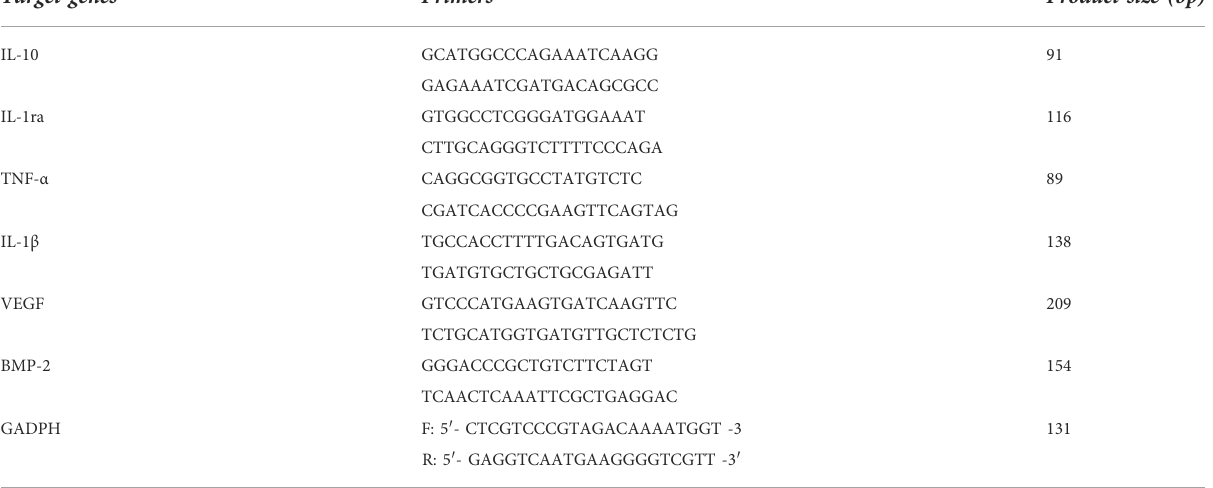
TABLE 1 The chain reaction for real-time polymerase of some in fl ammatory